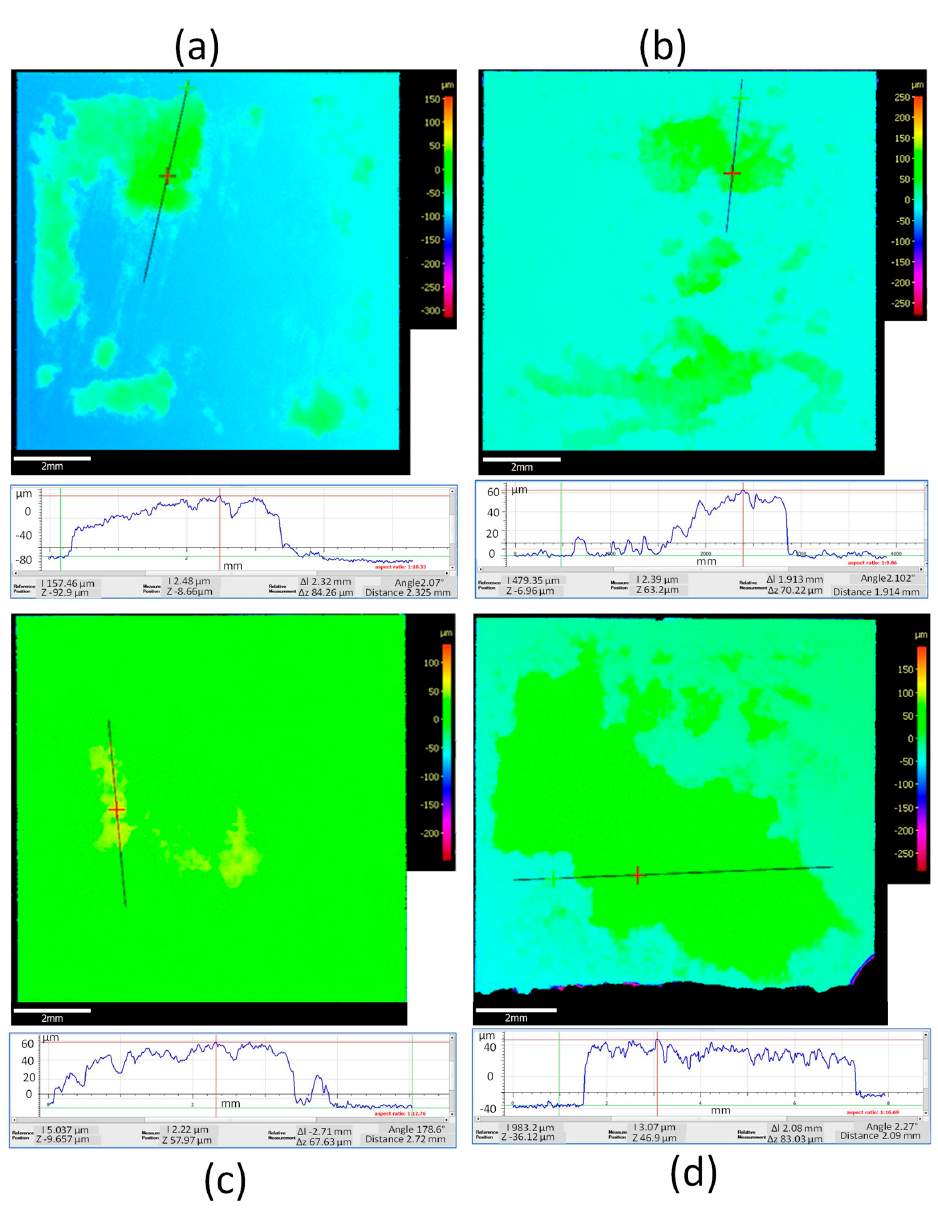
Figure 6. 3D mapping of the thickness of the coated samples: ( a ) Test C, ( b ) Test D, ( c ) Test E, ( d ) Test F. Test